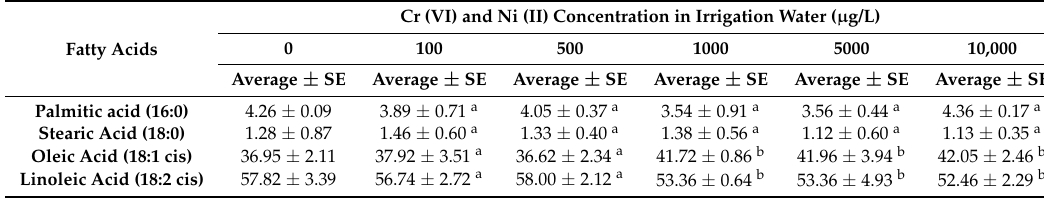
Table 4. Levels of fatty acids in sunflower